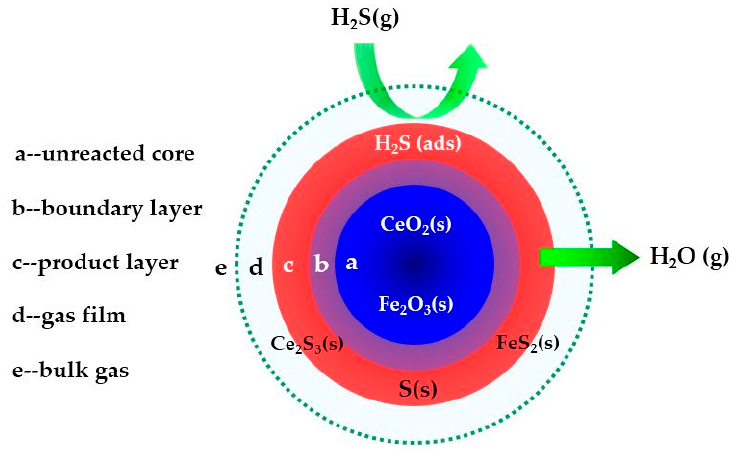
Figure 8. Schematic diagram of sulfidation process.